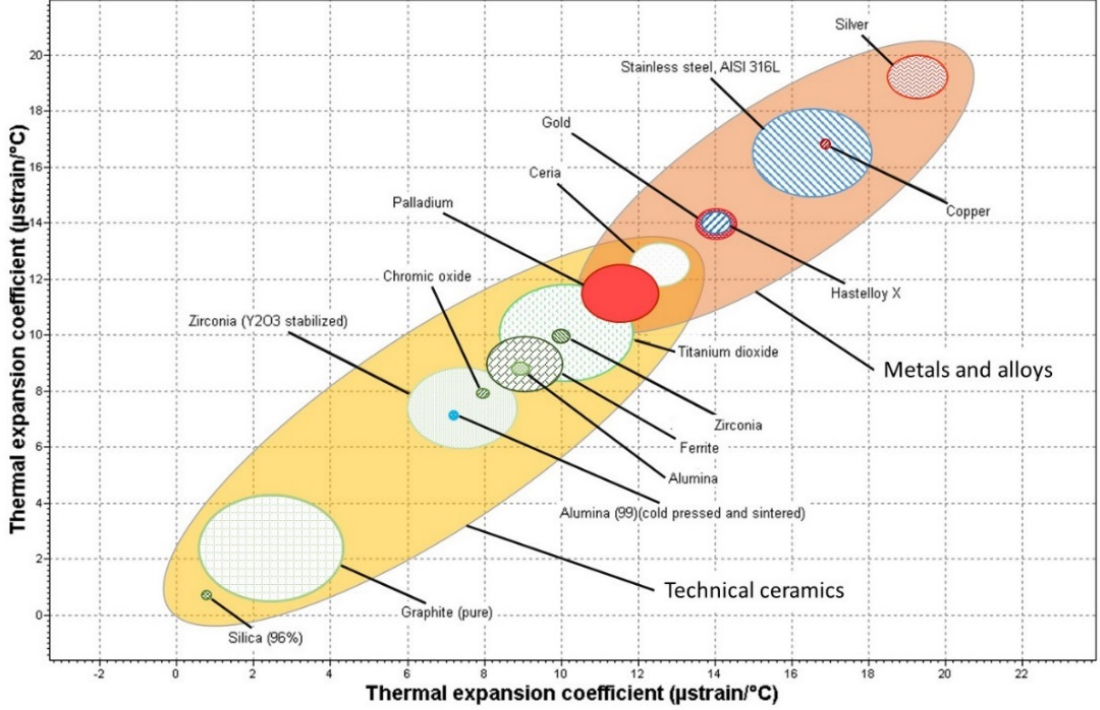
Figure 3. Thermal expansion coefficients for typical constituents of supported membranes for hydrogen separation.